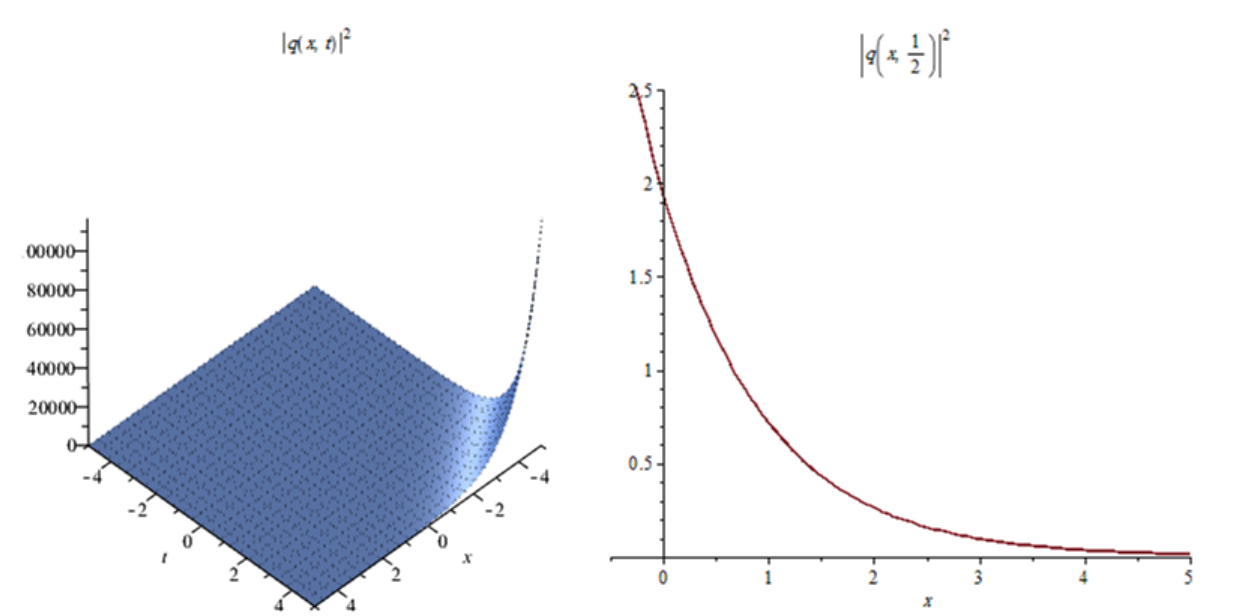
Figure 14. The profile of the combination of bright-dark soliton solutions (55). Figure 15: The numerical simulations of the solutions (55) 3D and 2D (with t = 1 with the parameter values a 1 = 1, a 2 = 1, b =